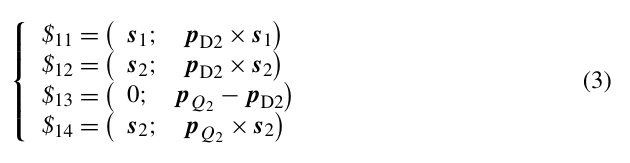
tubes are able to slide along axes A 1 B 1 and A 2 B 2 , respec-